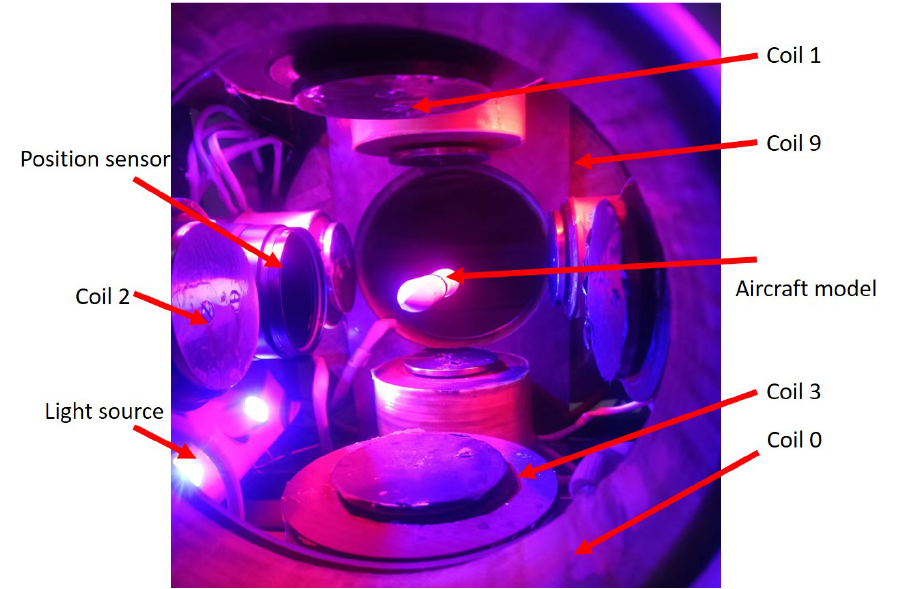
Figure 10. The MSBS test